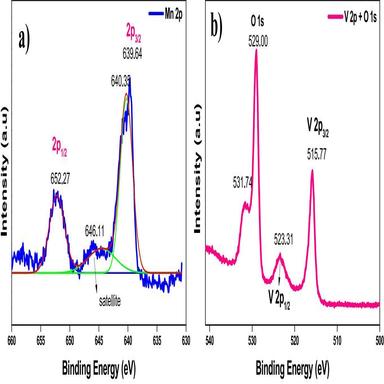
XPS spectra of IL-β-MNV a) Mn 2p, and b) V 2p, O 1s regions with labelled binding energies.